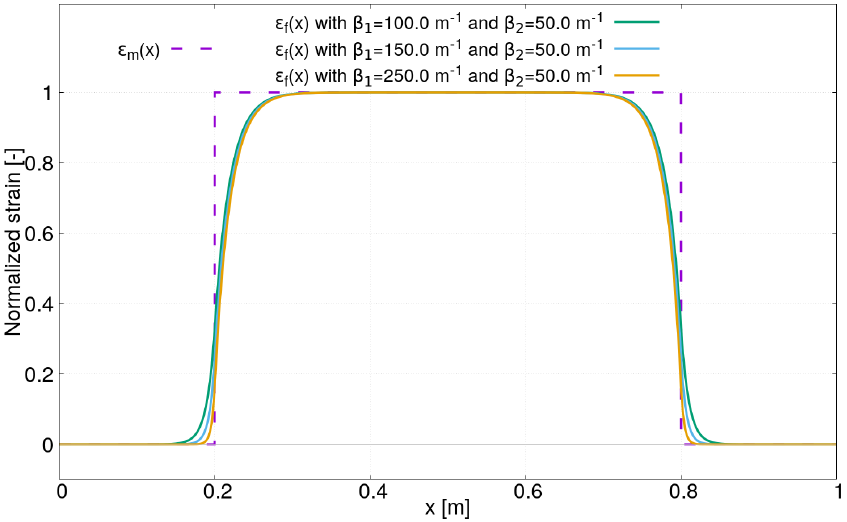
Figure 3. Strain profiles (cid:101) f ( x ) under uniform field for different strain lag paramaters β 1 = 100, 150,250 m − 1 and β 2 = 50 m − 1